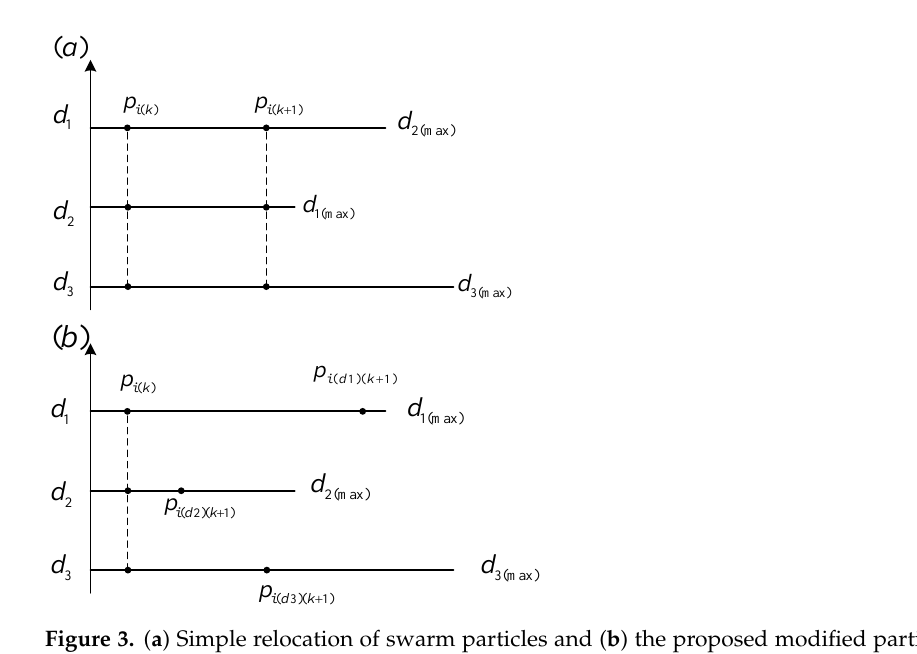
Figure 3. ( a ) Simple relocation of swarm particles and ( b ) the proposed modified particle swarm optimization (MPSO) bas